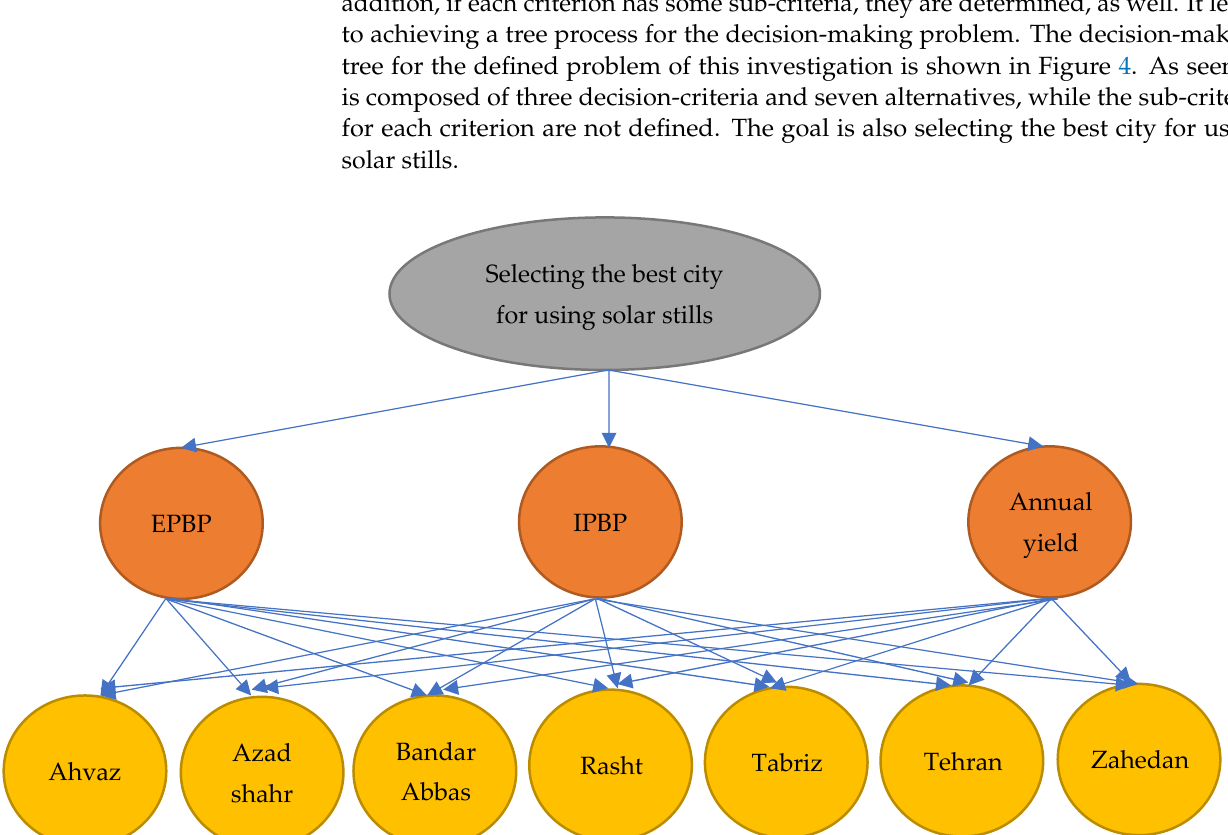
Figure 4. The defined decision-making tree of this investigation.